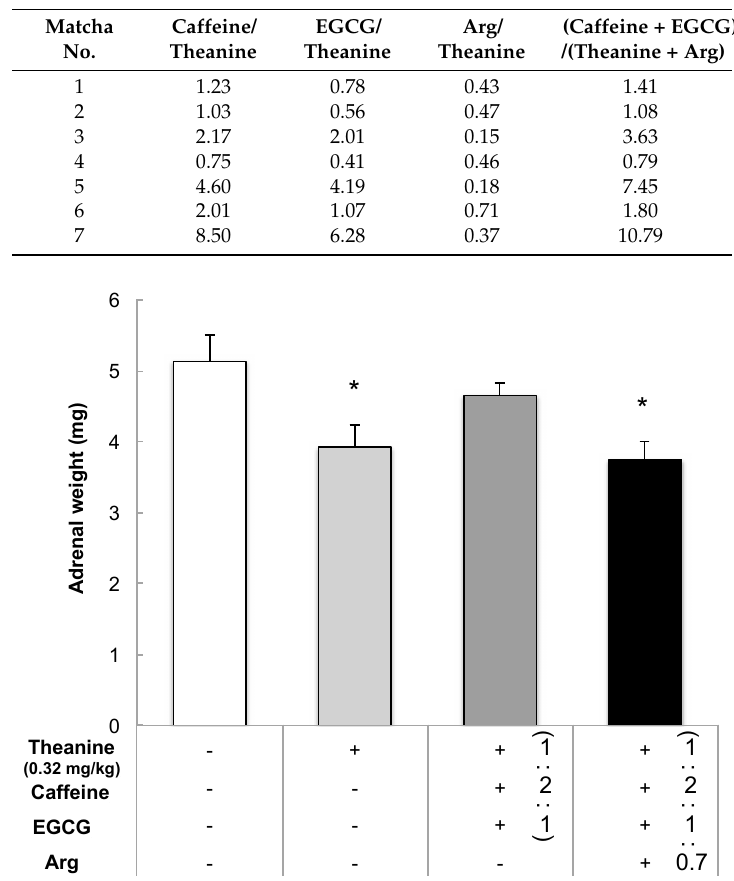
Figure 3. Interaction of tea components on adrenal hypertrophy in stressed mice. Mice consumed powder diet containing theanine, caffeine, EGCG, and Arg for seven days (single rearing for six days and confrontational rearing for one day). Control mice were fed a powder diet, CE-2. The concentration of theanine was 0.32 mg/kg. Mice ingested feed that contained each component as molar ratios of matcha sample no. 6, i.e., the molar ratio of theanine:caffeine:EGCG:Arg was 1:2:1:0.7. Each bar shows the mean ± SEM ( n = 4; * p < 0.05).